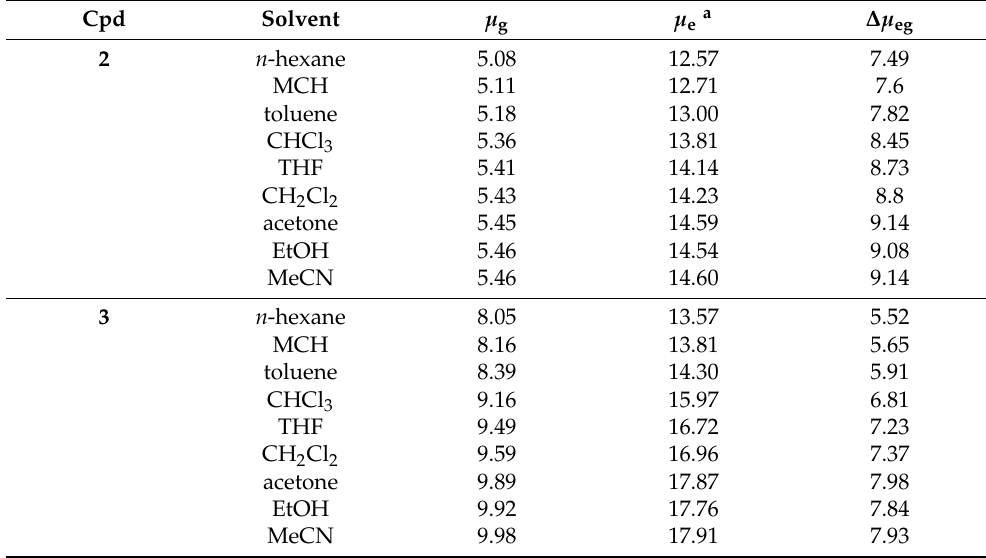
Table 3. Calculated ground ( µ g ) and excited ( µ e ) states of D- π -A compounds 2 and 3 in solvents of varied